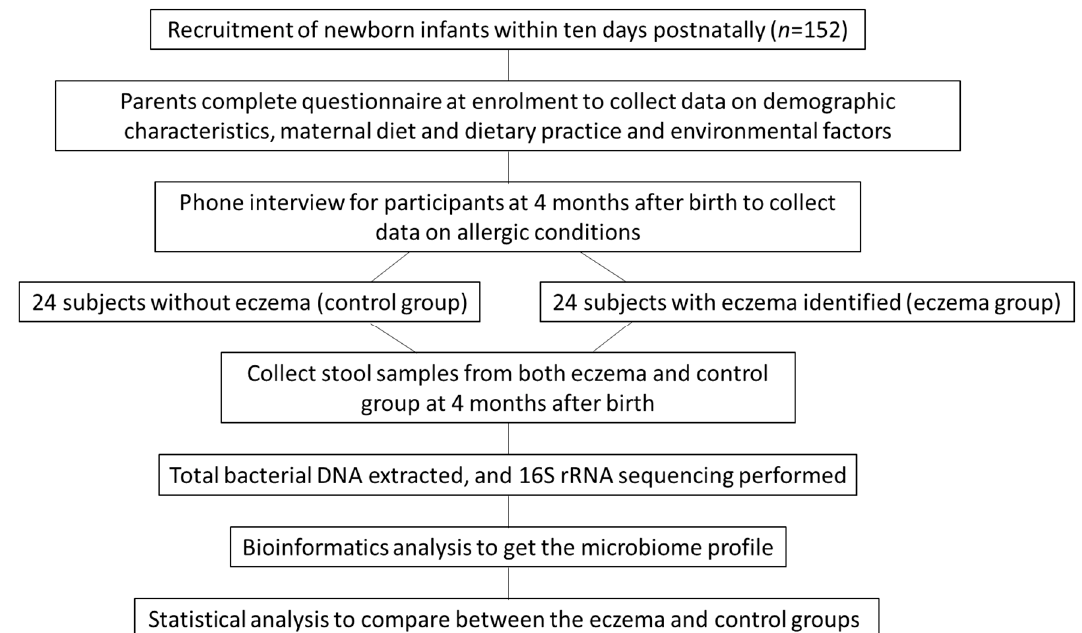
Figure 1. Diagram showing the procedural flow of the study.